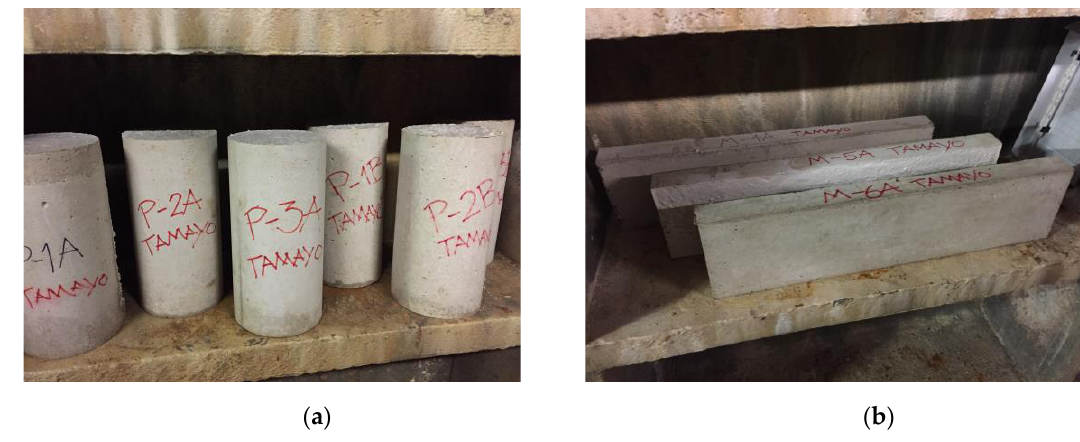
Figure 4. Curing process. ( a ) Cylindrical specimens; ( b ) Rectangular specimens.